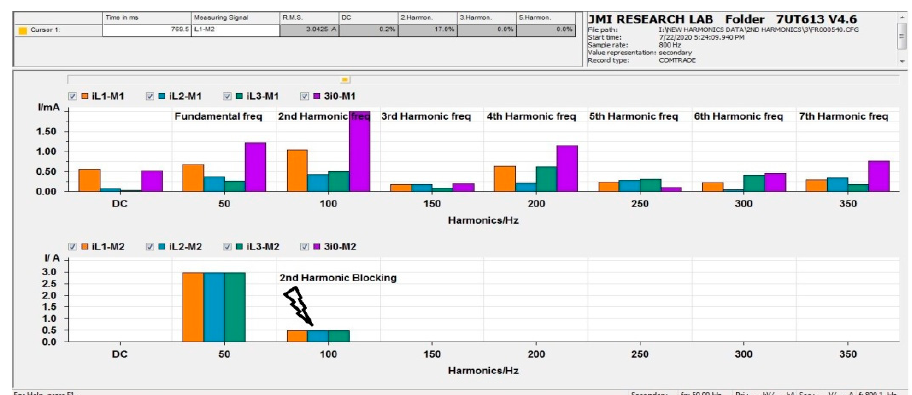
Figure 13. 2nd HB at 2000 mA Rated current & 20% of Inrush current condition.